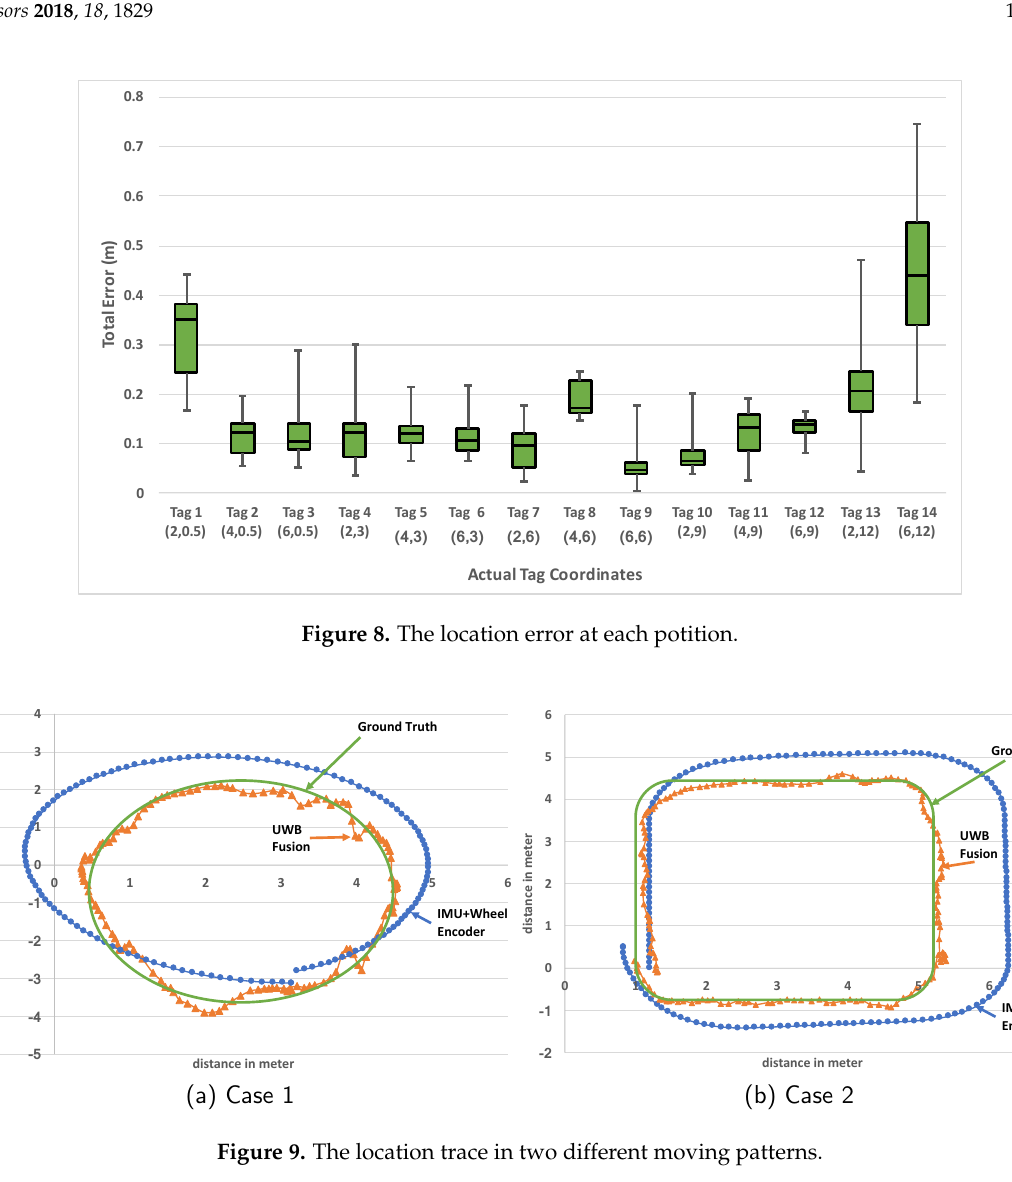
Figure 9. The location trace in two different moving